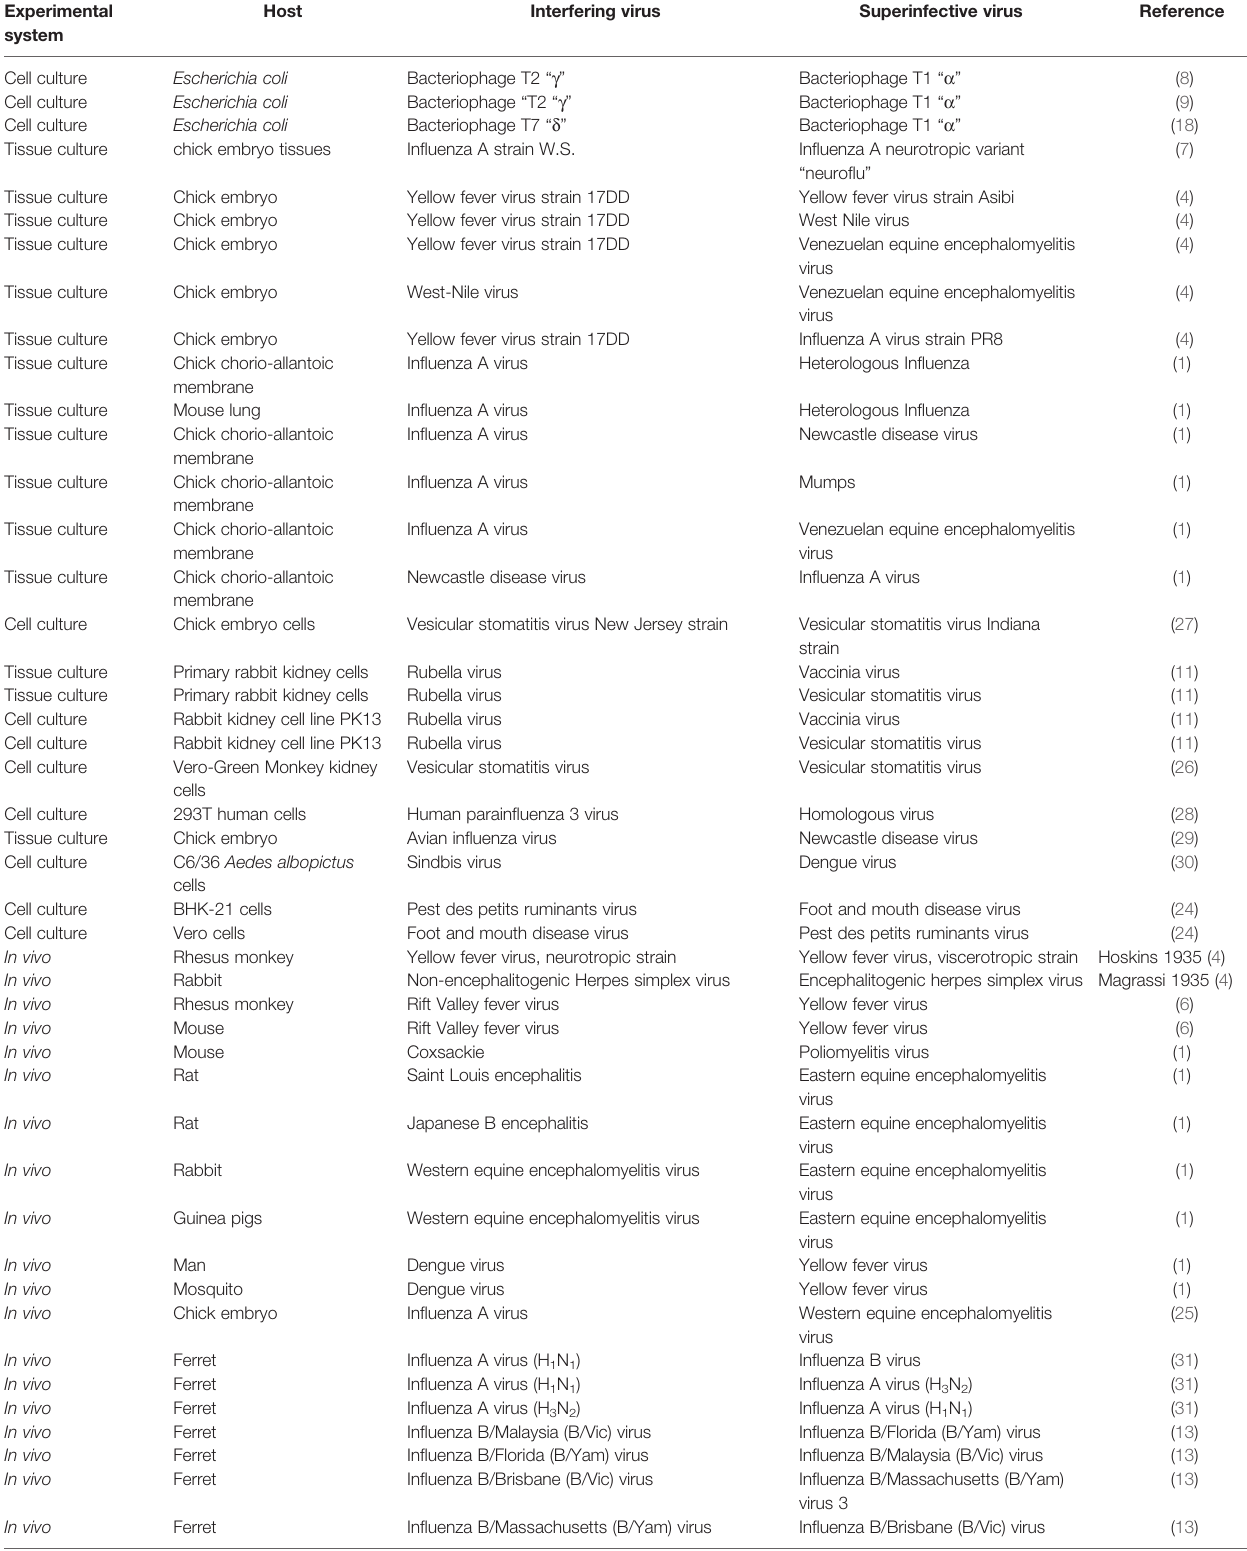
TABLE 1 | Virus interference in different animal hosts using different experimental systems. Experimental